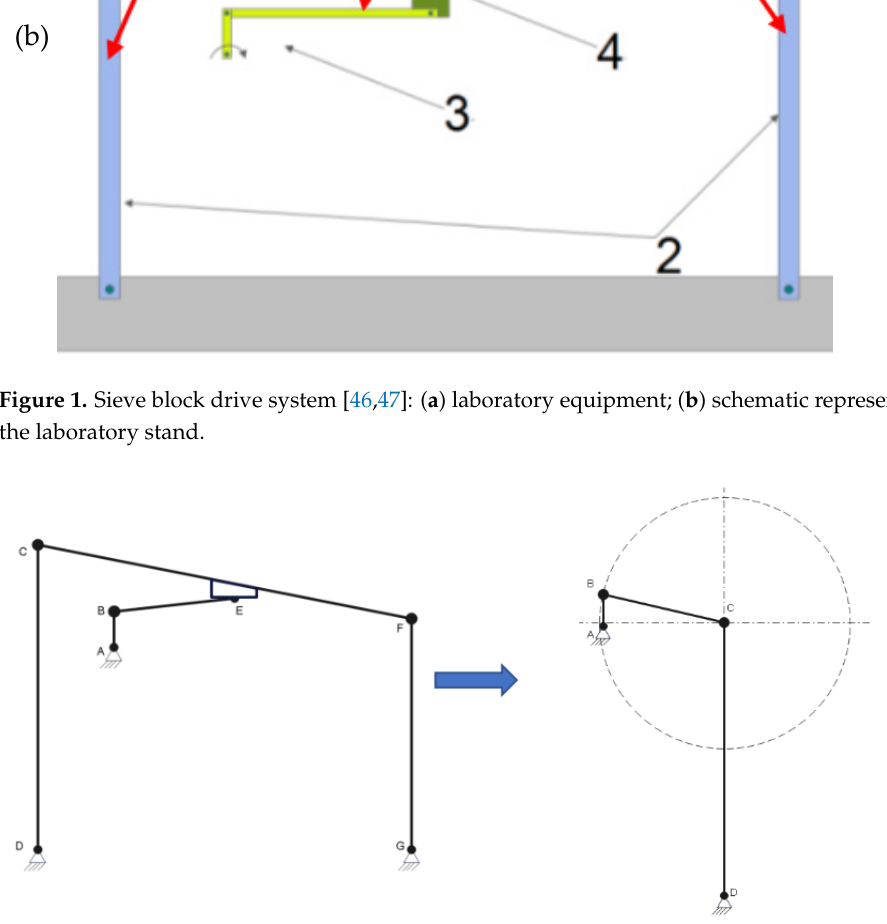
Figure 2. Model of the mechanism under study: ( a ) scheme for the drive system; ( b ) simplified model.